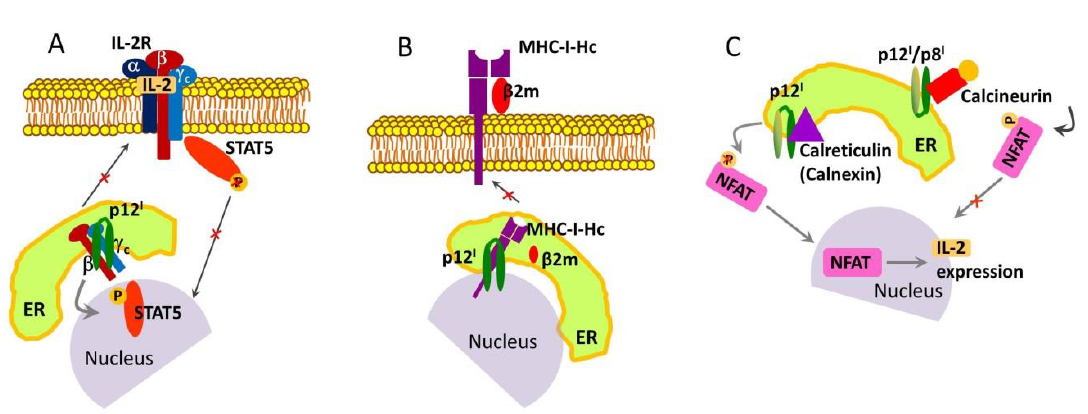
Figure 2. Mechanisms of p12 I in the endoplasmic reticulum (ER) of infected cells: ( A ) p12 I binds to the immature forms of interleukin-2 receptor (IL-2R) β and γ c subunits preventing their traffic to the plasma membrane and the assembly of IL-2/IL-2R complex, and hence, inhibits signal transducer and activator of transcription 5 (STAT5) activation. However, upon binding to p12 I , the β and γ c subunits co-localize and provide new way for STAT5 phosphorylation and activation. Thus, p12 I re-routes the STAT5 signaling pathway. ( B ) Through binding to the free human MHC-I heavy chain (MHC-I-Hc), p12 I obliterates the assembly of functional MHC-I-Hc– β 2m complex in the plasma membrane resulting in suppression of immune response. ( C ) p12 I has a mechanism to increase the concertation of Ca 2+ in the cytoplasm while depleting Ca 2+ from the ER, which affects the Ca 2+ signaling in the cell. To do so, p12 I interacts with host proteins (calreticulin and calnexin), which modulate Ca 2+ storage. As a result, dephosphorylated nuclear factor of T cells (NFAT) migrates to the nucleus and induces IL-2 expression and T-cell activation. Other possible role is that p12 I interacts with calcineurin, thus inhibiting NFAT.